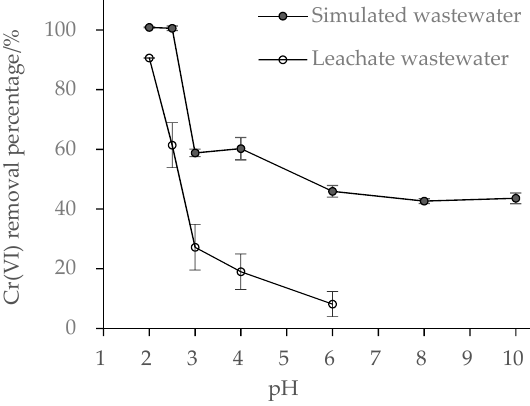
Figure 3. Effect of initial pH values on Cr (VI) removal ( n = 3) from wastewaters by BFe 0 NPs (4%).